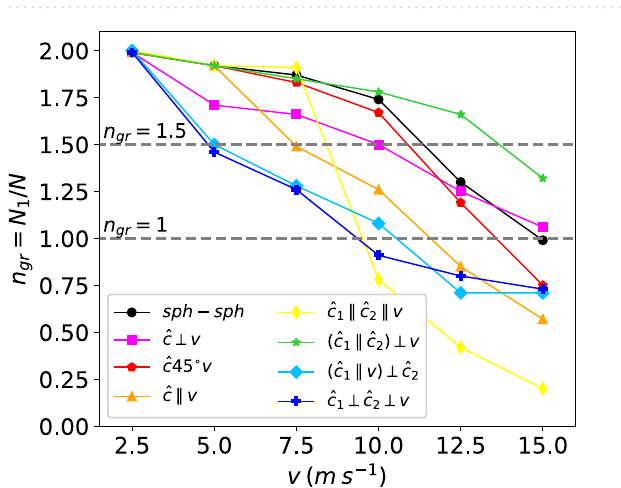
Figure 3. Angular distribution of monomers, N m (θ) , for collision velocity of v = 15 m/s and the collision geometries indicated, cf. Table 1. Data are normalized to their peak values.